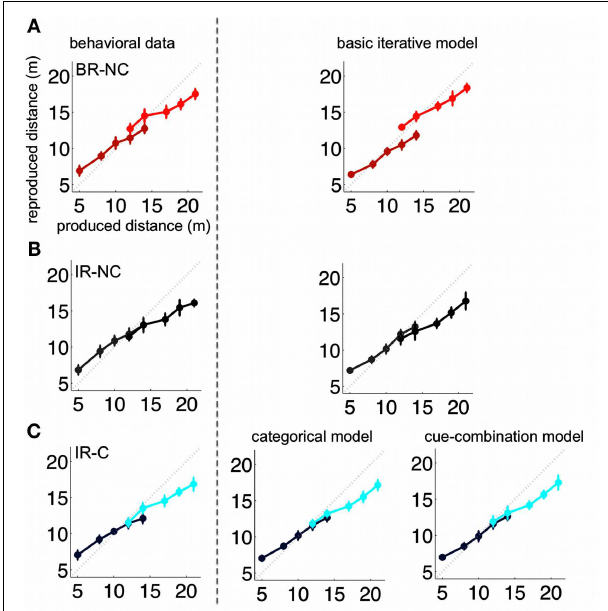
FIGURE 5 | Group mean of all subjects (left) and respective model predictions (right). The group mean corresponds to the mean taken over all subjects for the whole trial sequence. Models were accordingly fitted to the resulting “mean trial sequence.”The rows (A–C) show the results for the three conditions BR-NC, IR-NC, and IR-C respectively.The IR-NC and BR-NC were fitted with the basic iterative model introduced in Petzschner and Glasauer (2011). Predictions for the cue condition IR-C were generated with the categorical as well as cue-combination model. Error bars depict the standard deviation of the reproduced distances across trials.